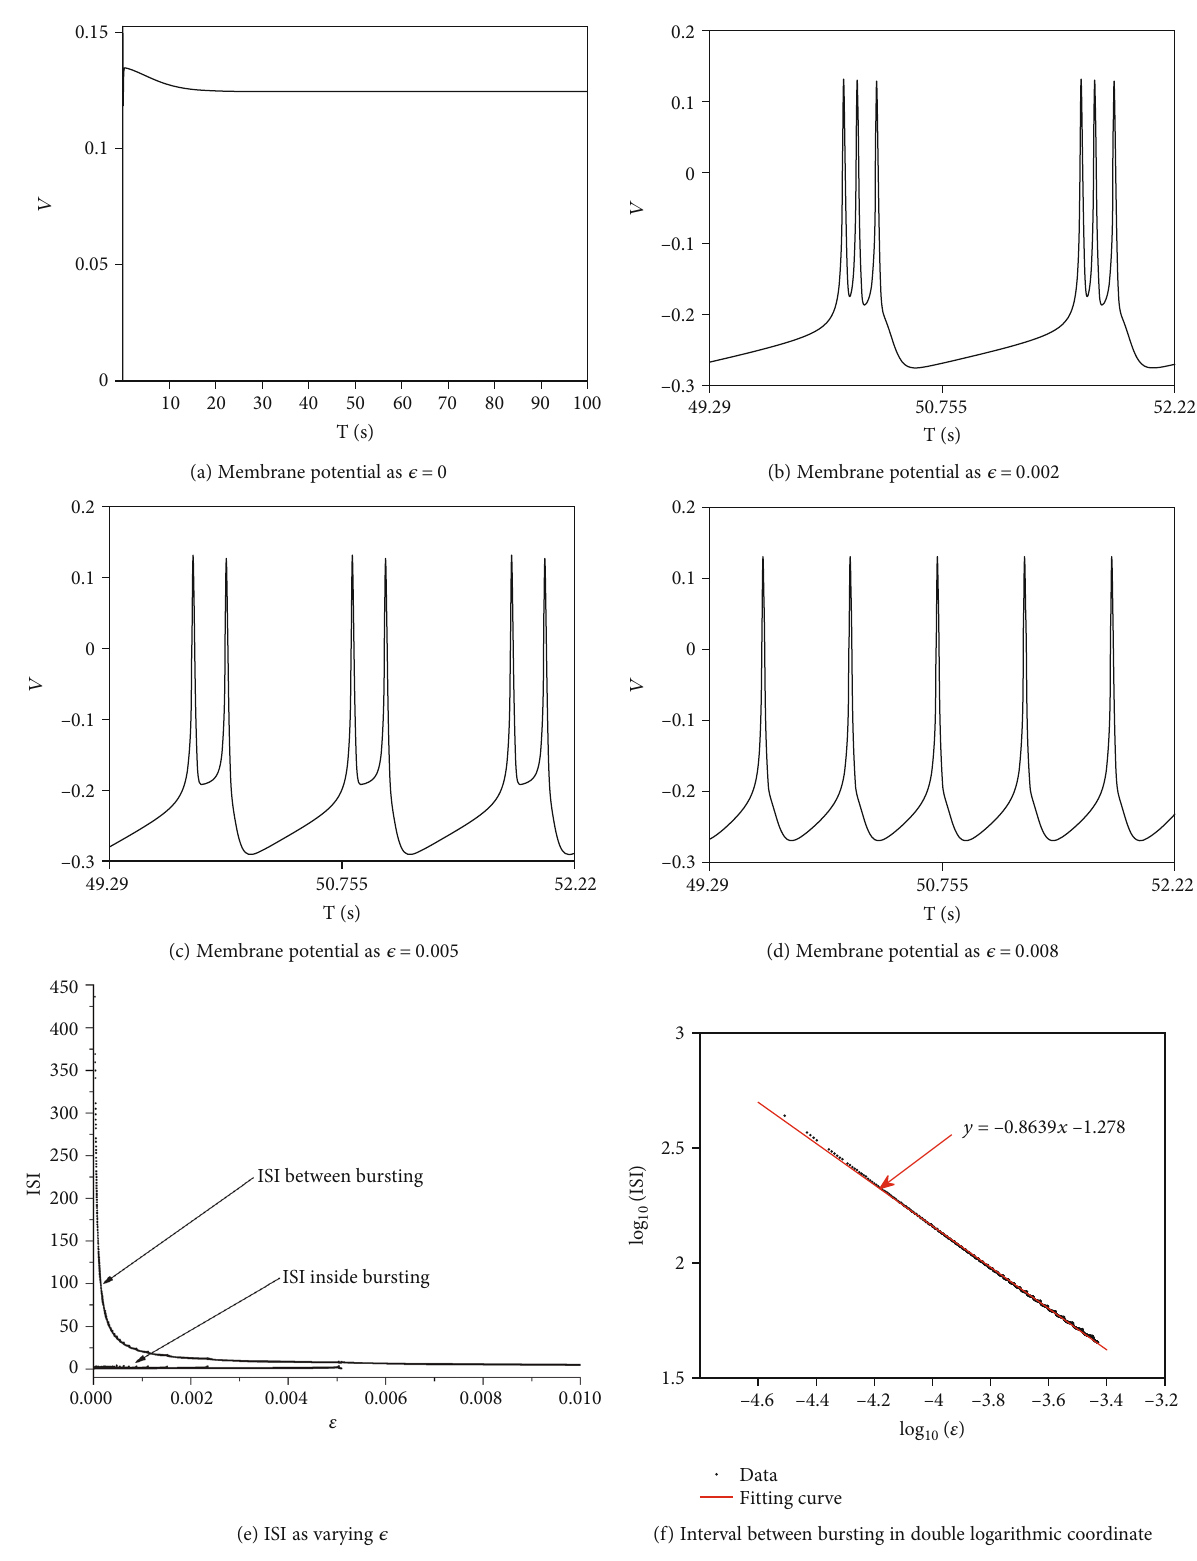
Figure 5: Membrane potential and ISI diagram varying ϵ with electromagnetic induction ( k = 0mMs ‐ 1 ( r IP 3